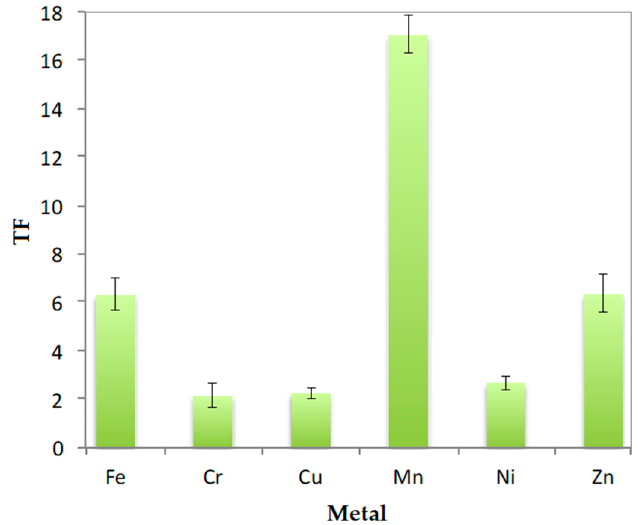
Figure 6. Translocation factors in the plant grown in CS after 90 days.